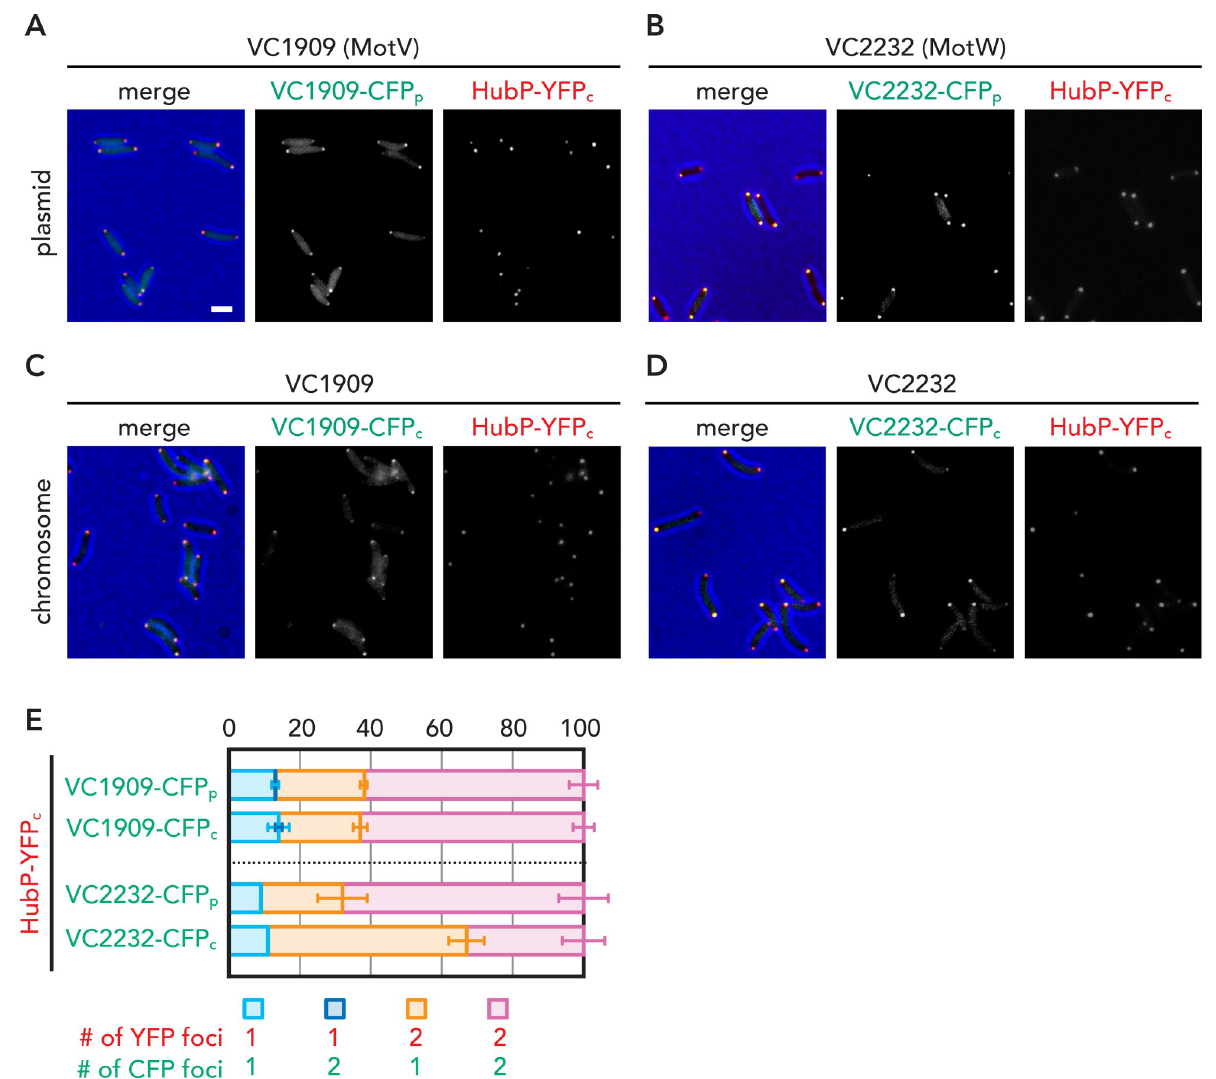
Fig 2. Bipolarity of polar proteins. (A-D) Representative fluorescent microscopy images of cells expressing indicated fluorescent protein fusions expressed from either plasmid ( p ) or native chromosomal locus (referred as c ). (E) Fraction of cells (%) exhibiting uni- (1) or bi- (2) polar foci. Average and standard deviations of 2 independent analyses (each counted > 1000 cells) are